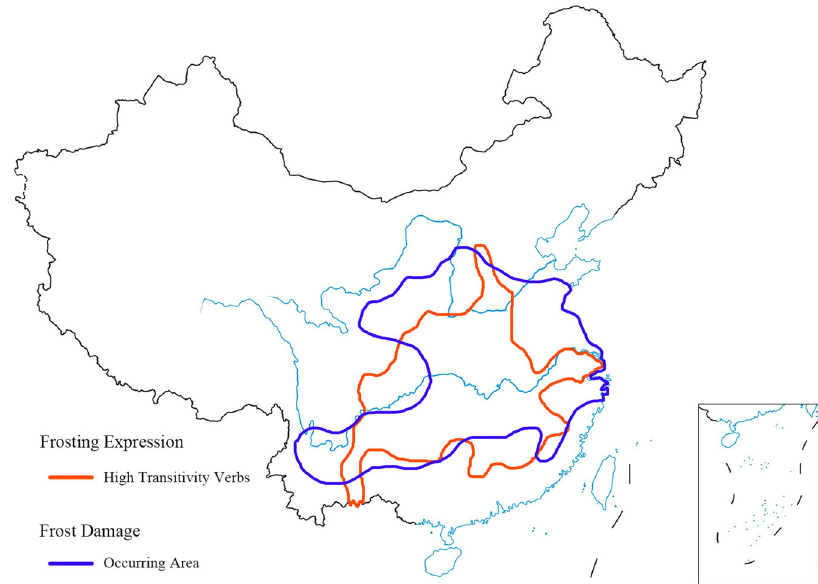
Fig. 3 Map of distribution of frost expressions with high transitivity verbs and frost damage areas. The red line is the isogloss of frosting expressions using high transitivity verbs, the blue line borders the area with frost damage.